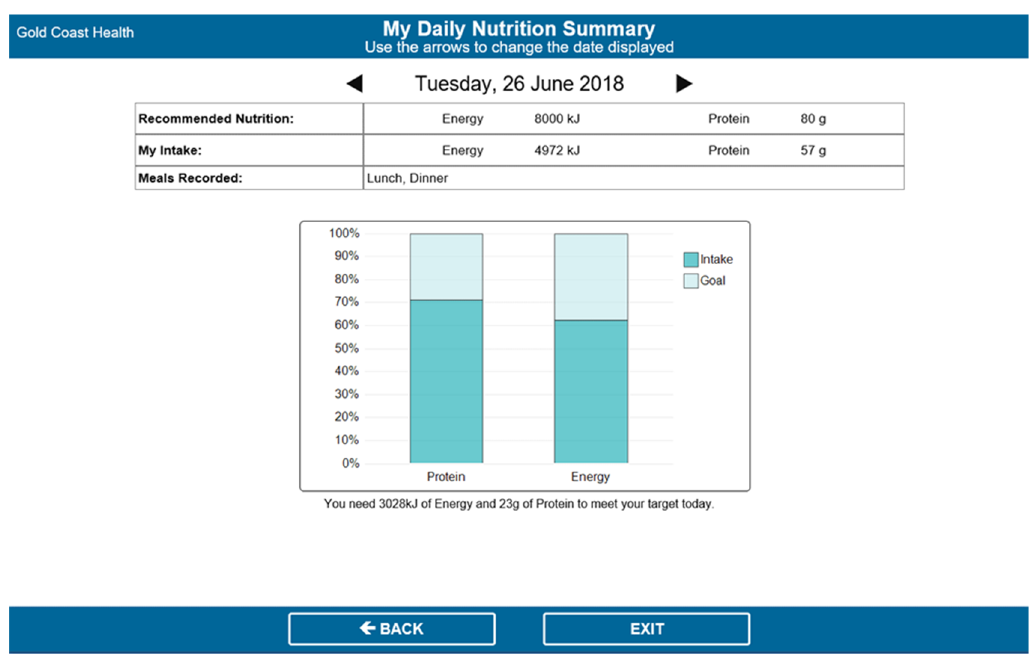
Figure 1. Intake tracking page in the electronic foodservice system (EFS).